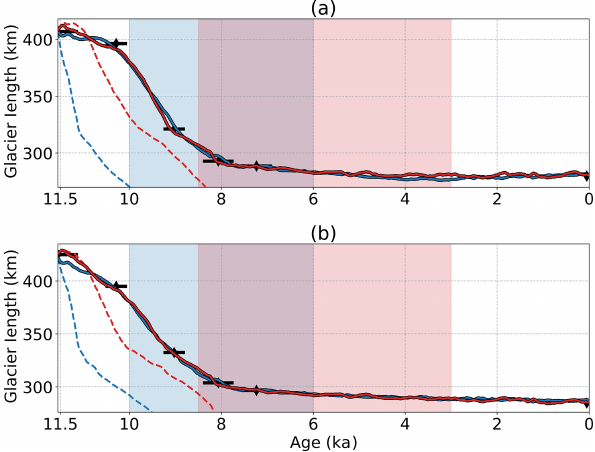
Figure 8. Modeled retreat histories for the northern (a) and southern (b) flow lines using a variety of (cid:49)T and (cid:49)P forcings. Blue and red lines show modeled retreat using Buizert et al. (2018) and Dahl- Jensen et al. (1998) temperature forcings, respectively. Dashed lines show the results of forcing the model with (cid:49)P = 0, while solid lines show the results of using optimal estimated precipitation anomalies. Black diamonds and bars show reconstructed terminus positions, along with 95% confidence intervals. Shaded blue and pink regions demarcate the extent of the HTM for the Buizert et al. (2018) and Dahl-Jensen et al. (1998) reconstructions, respectively.